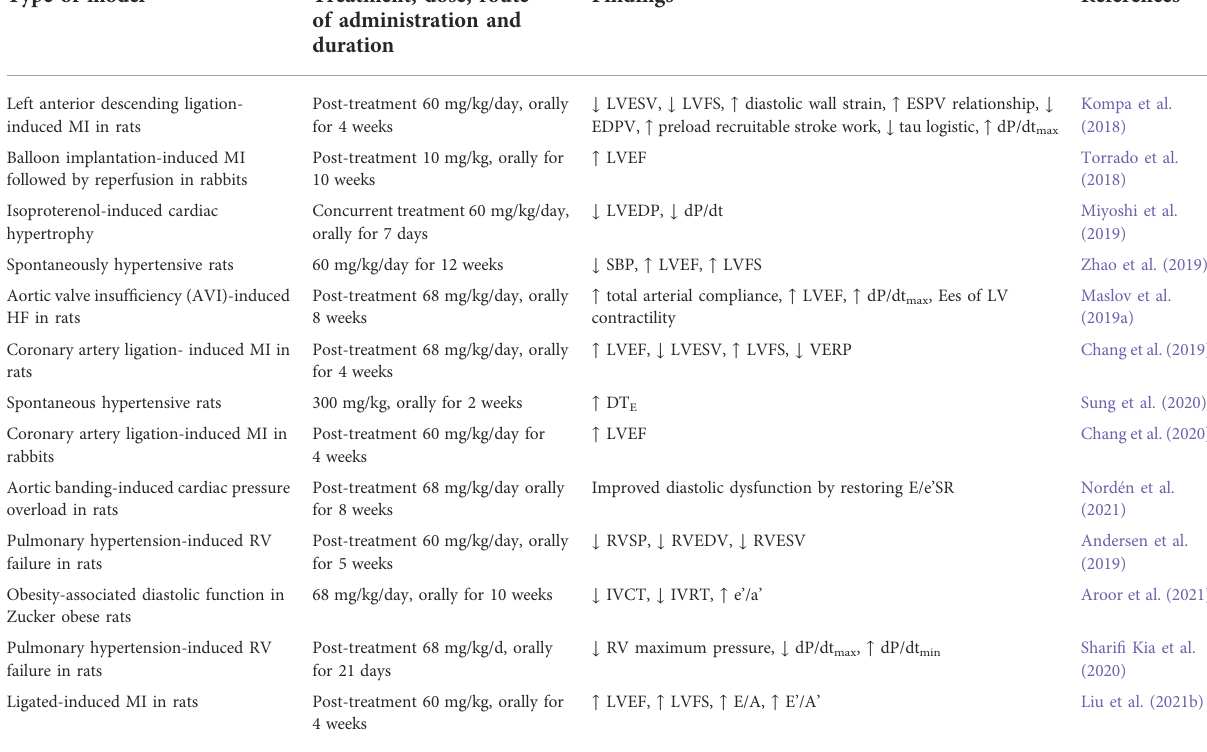
TABLE 2 The effects of sacubitril/valsartan on cardiac function in animal